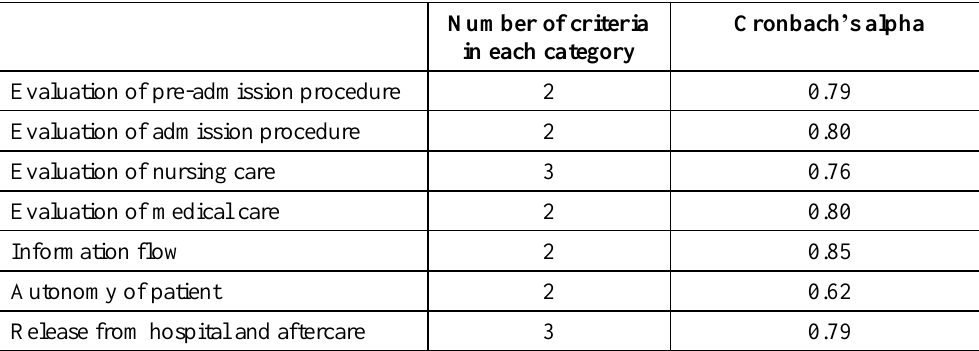
Table 3. Criteria Receiving the Highest Score for Determination of Patient Satisfaction and Willingness to Recommend the Hospital Number of criteria Cronbach’s in each category